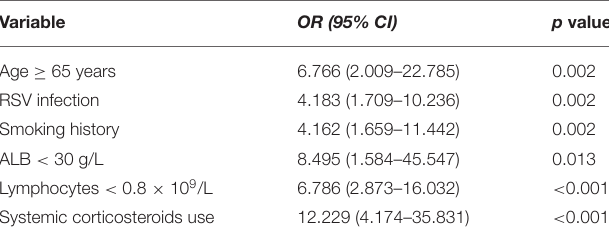
TABLE 4 | Risk factors for 30-day mortality of three types of